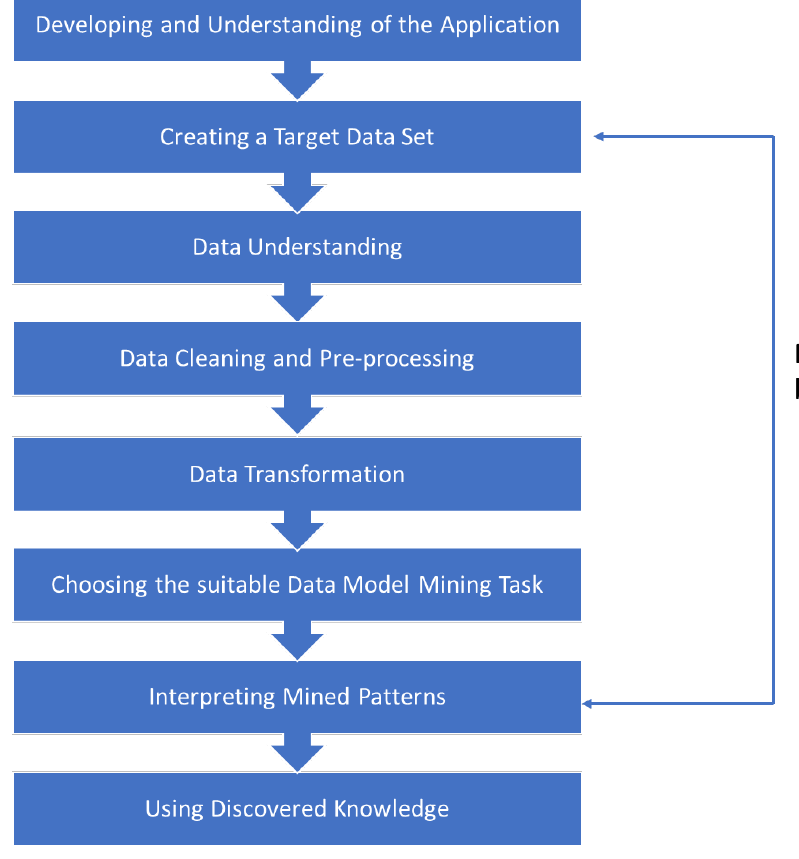
Figure 4. Proposed model.